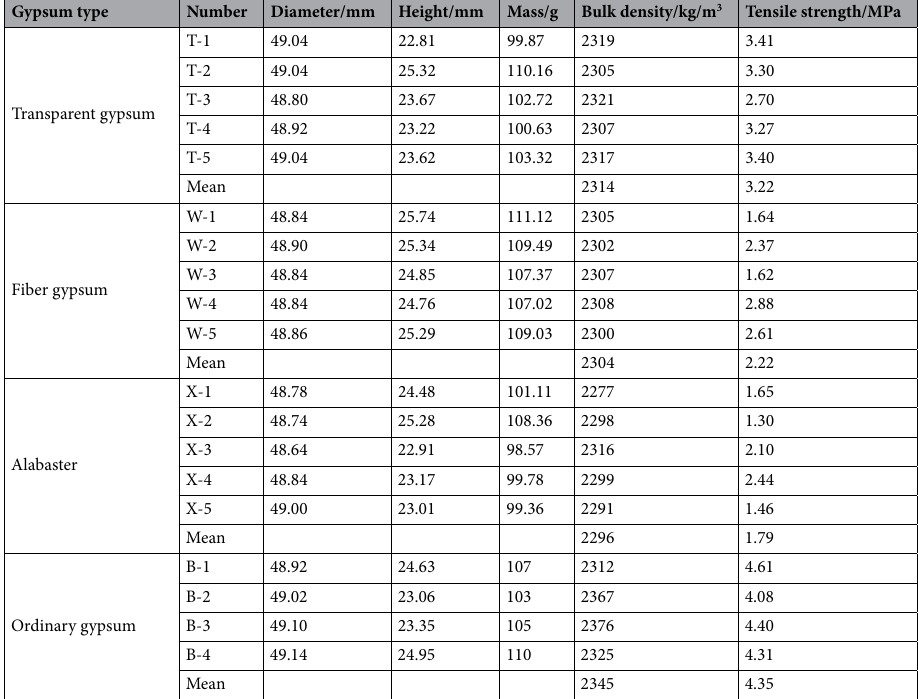
Table 3. Brazilian splitting test results.